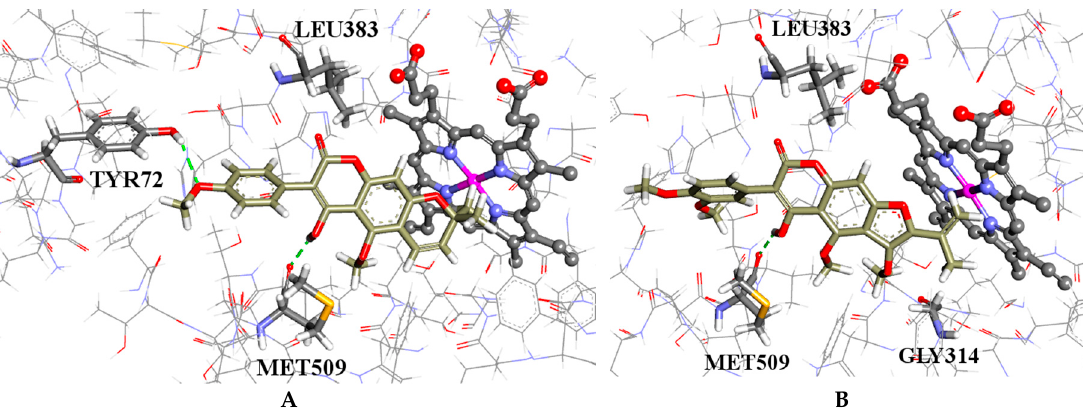
Figure 3. ( A ) the docked configuration of robustic acid ( 1 ) in the binding site of lanosterol 14 α -demethylase (CYP51); and ( B ) the docked configuration of thonningine-C ( 2 ) in the binding site. Hydrogen bonds are shown as green dotted lines.